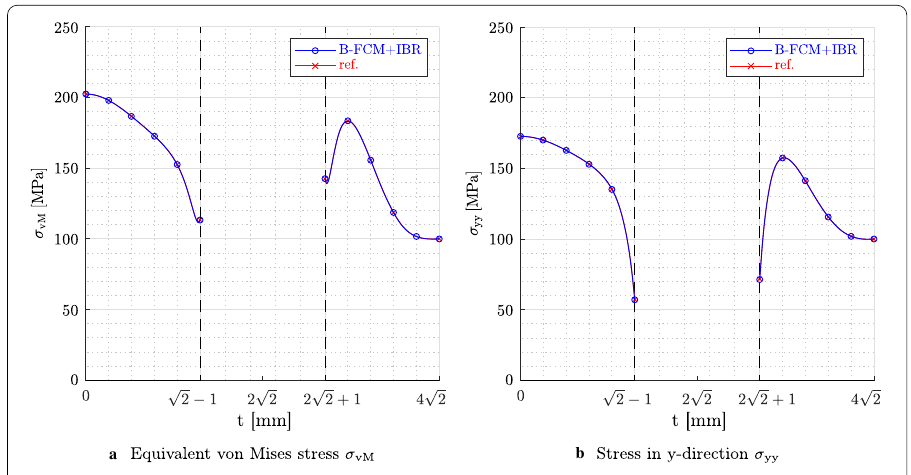
Fig. 23 Stresses along the diagonal cut-line AB depicted in Fig. 21 for the B-FCM + IBR approach and for the reference solution. The dashed lines indicate the start and end of the hole along the cut-line. Using the other compression techniques as well as using no compression results in the same depicted